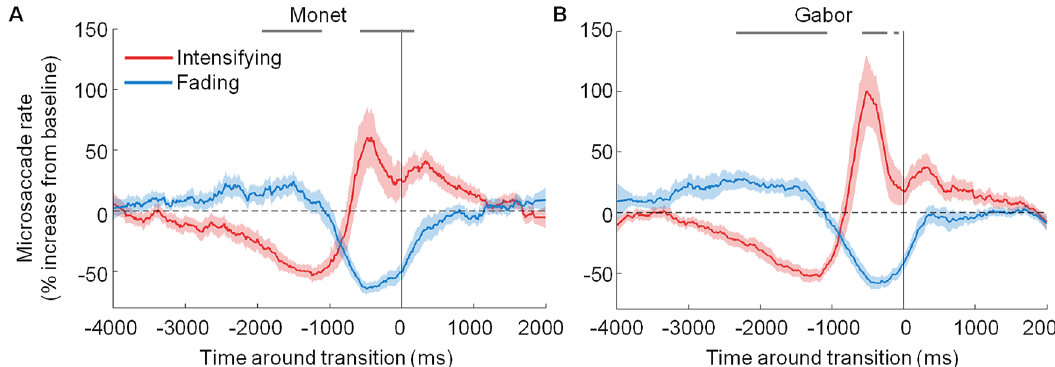
Figure 3. Microsaccade dynamics before transitions toward perceptual intensification versus fading. Average probability of microsaccades before transitions toward perceptual intensification (red) versus fading (blue) for ( A ) Monet’s sun and ( B ) a Gabor patch. The solid vertical line indicates the reported transitions (time = 0). The grey dashes along the top of the plots indicate the bins where microsaccade rates before transitions to intensification were significantly higher than microsaccade rates before transitions to fading (two-tailed paired t tests with Bonferroni correction, bin size = 20 ms, p < 0.05). Red and blue shading indicates the SEM across subjects (N = 22). Because trials from the two conditions were interleaved, both panels show data from the same participants, collected during the same